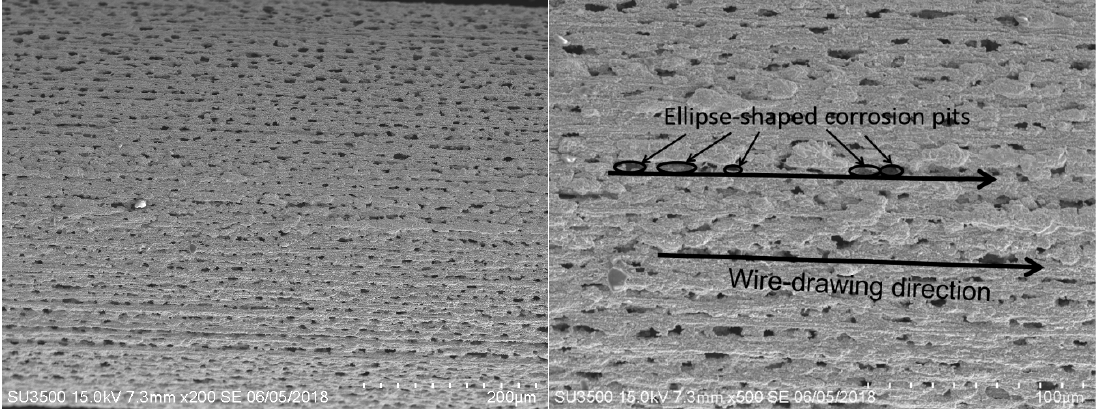
Figure 3. Surface morphology of IrRh10 after 60 h of high-temperature oxidation.